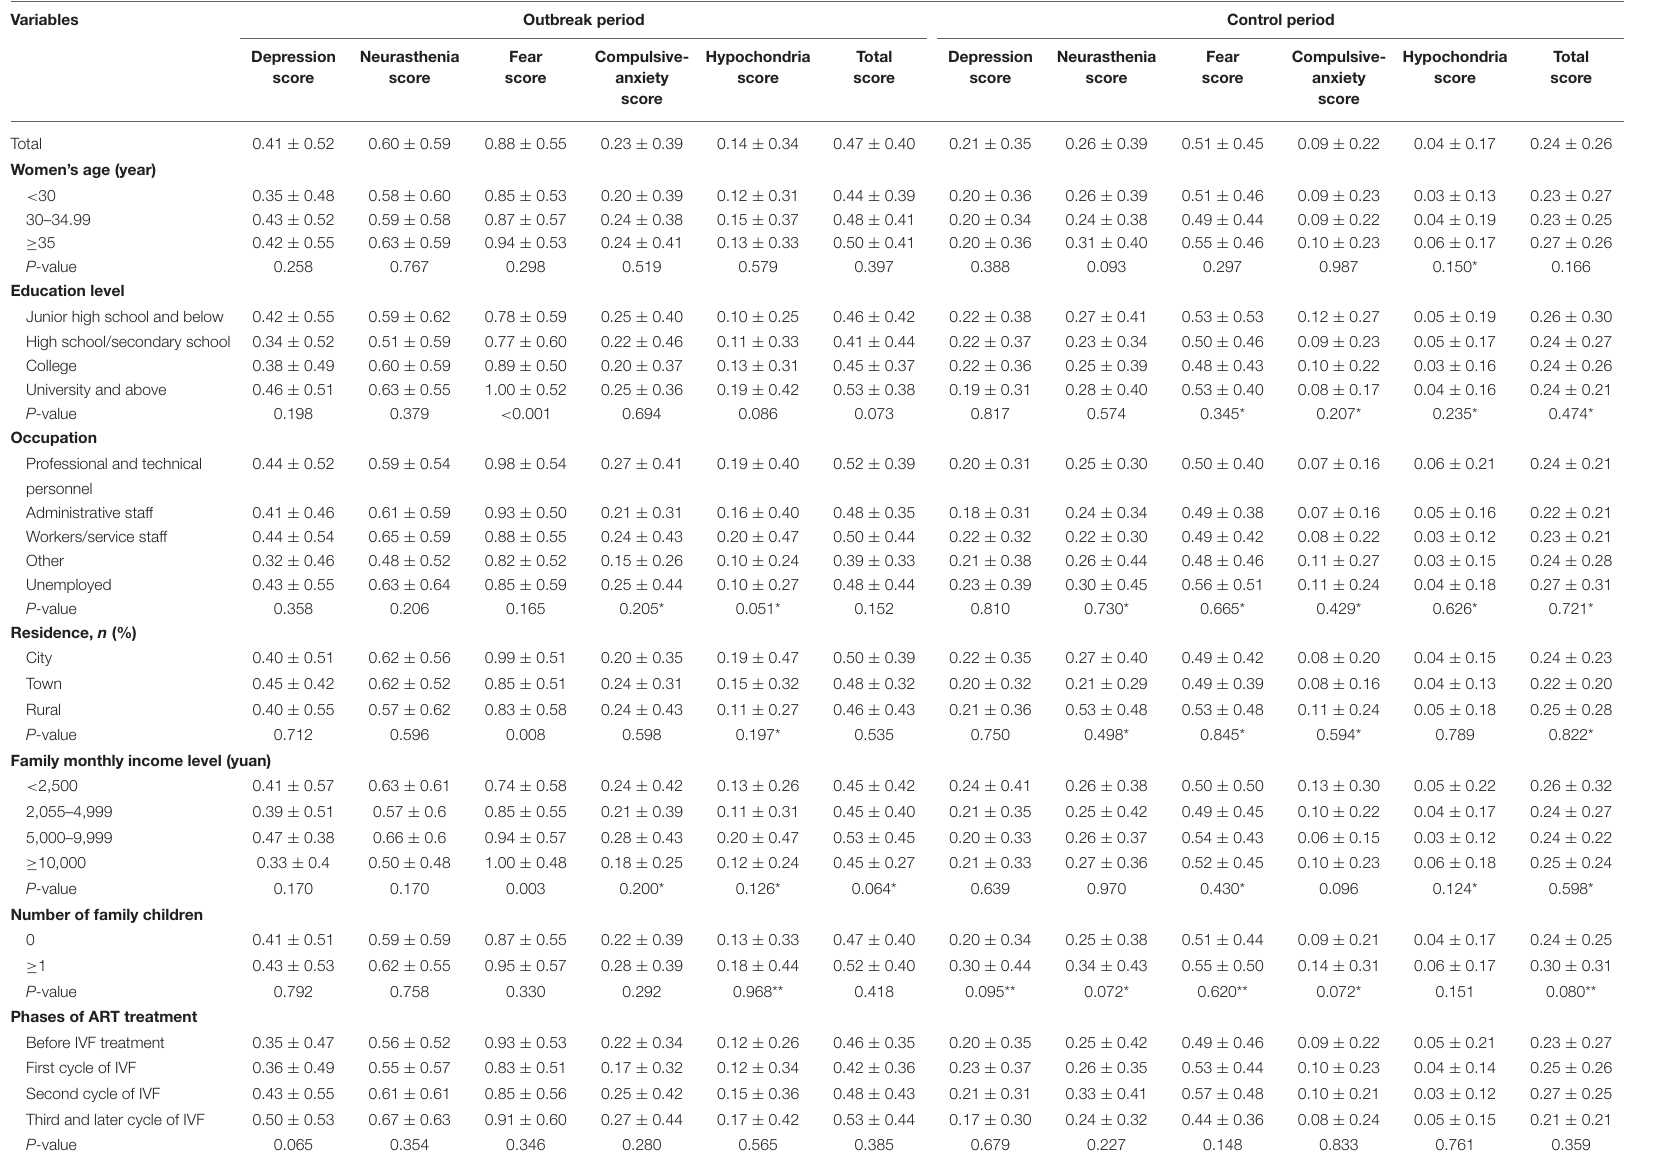
TABLE 2 | The psychological state of ART-treated women during the outbreak period and during the control period (Mean ± SD).